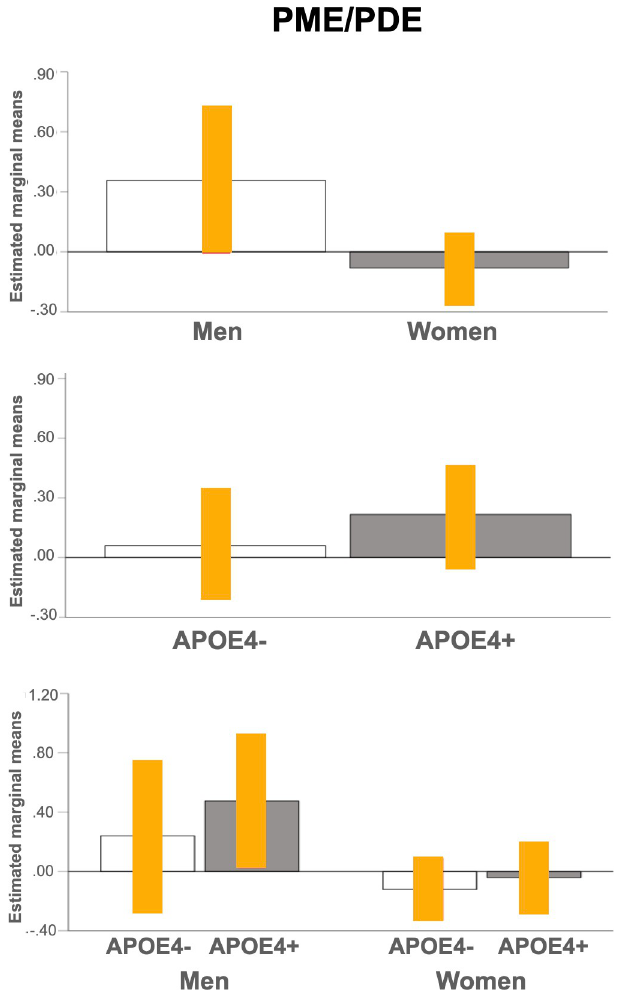
carriers; APOE4+, carriers; PDE, phosphodiesters; PME,